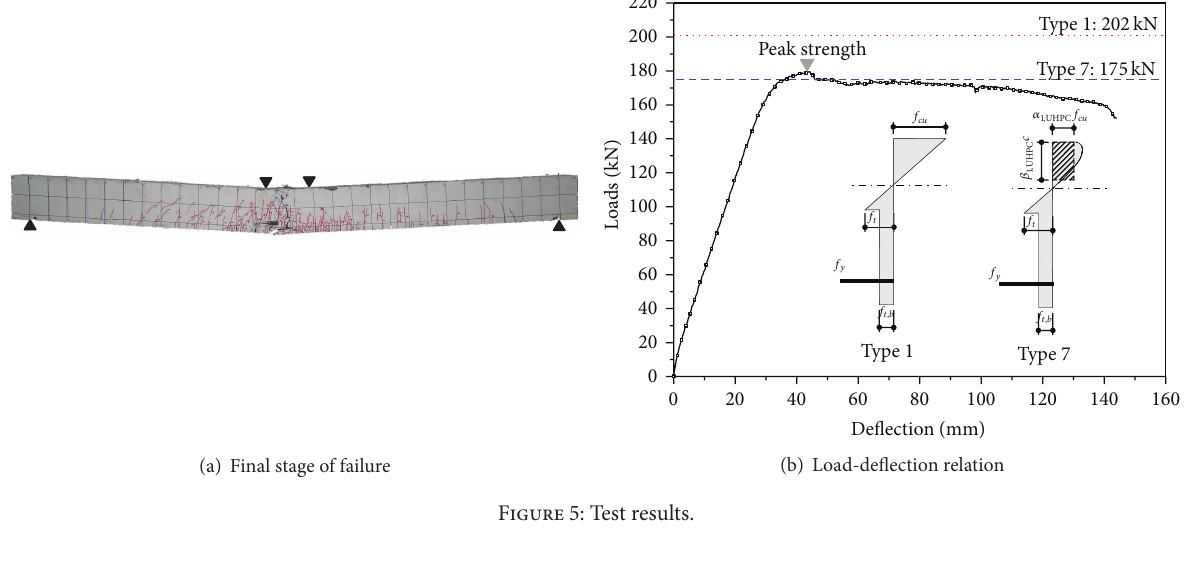
Figure 5: Test results.